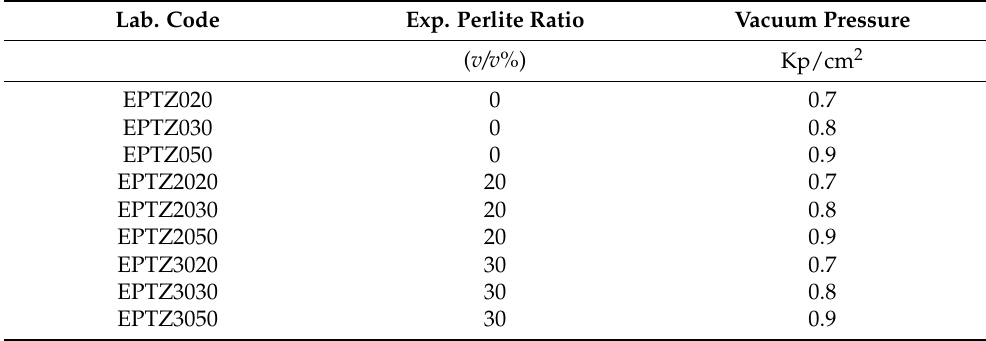
Figure 4. The extruder and the sample mouth of the extruder. Table 6. Mixture proportions of clay brick samples.